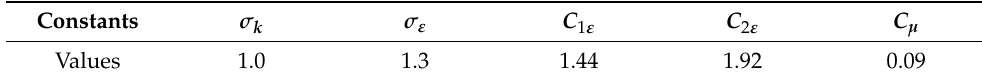
Table 2. Constant values in the k − ε model [9]. Constants σ